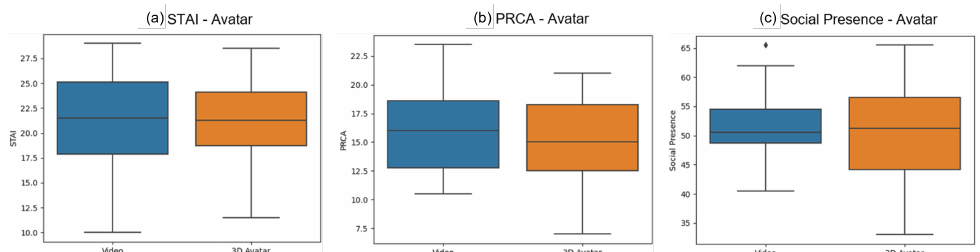
Figure 7. Effects of avatar type on the ( a ) levels of anxiety, ( b ) fear of public speaking, and ( c ) social presence.